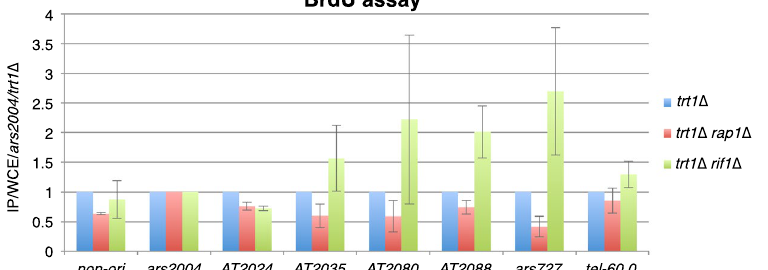
Figure 2. The rap1 ∆ strain shows replication timing defects in a telomere DNA-dependent manner. The rap1 ∆ trt1 ∆ strain showed replication timing similar to that observed in the trt1 ∆ strain at internal late origins in the absence of telomere DNA, whereas the rif1 ∆ trt1 ∆ strain showed accelerated replication at late origins. Cells with circular chromosomes were grown in YES medium, and the BrdU incorporation assays were performed as in Fig. 1B. Each value was normalized to that of ars2004 and then to the trt1 ∆ value.